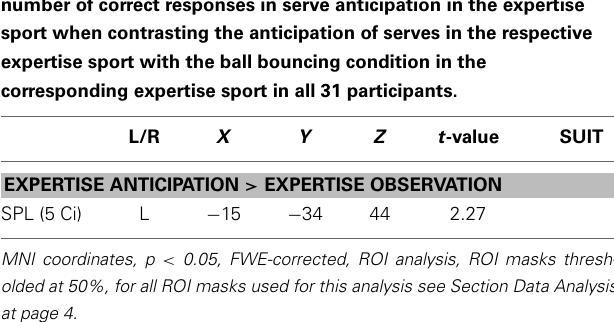
anticipation in the expertise sport for the contrast Expertise Anticipation > Expertise Observation in all 31 participants (blue marks). T maps were thresholded at t = 1 . 00 ( p < 0 . 05, FWE-corrected). Activation is rendered on a high-resolution T1 template (“colin brain”) as well as on the cerebellar SUIT template (Diedrichsen, 2006).